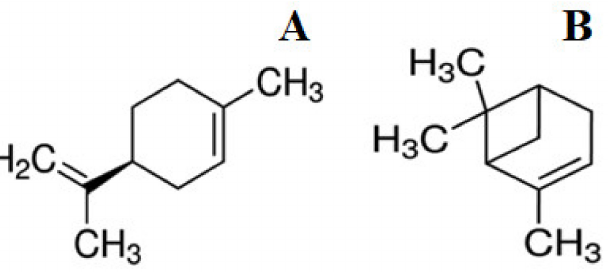
Figure 1. The chemical structure of ( − )-limonene ( A ) and (+)- α -pinene ( B ).